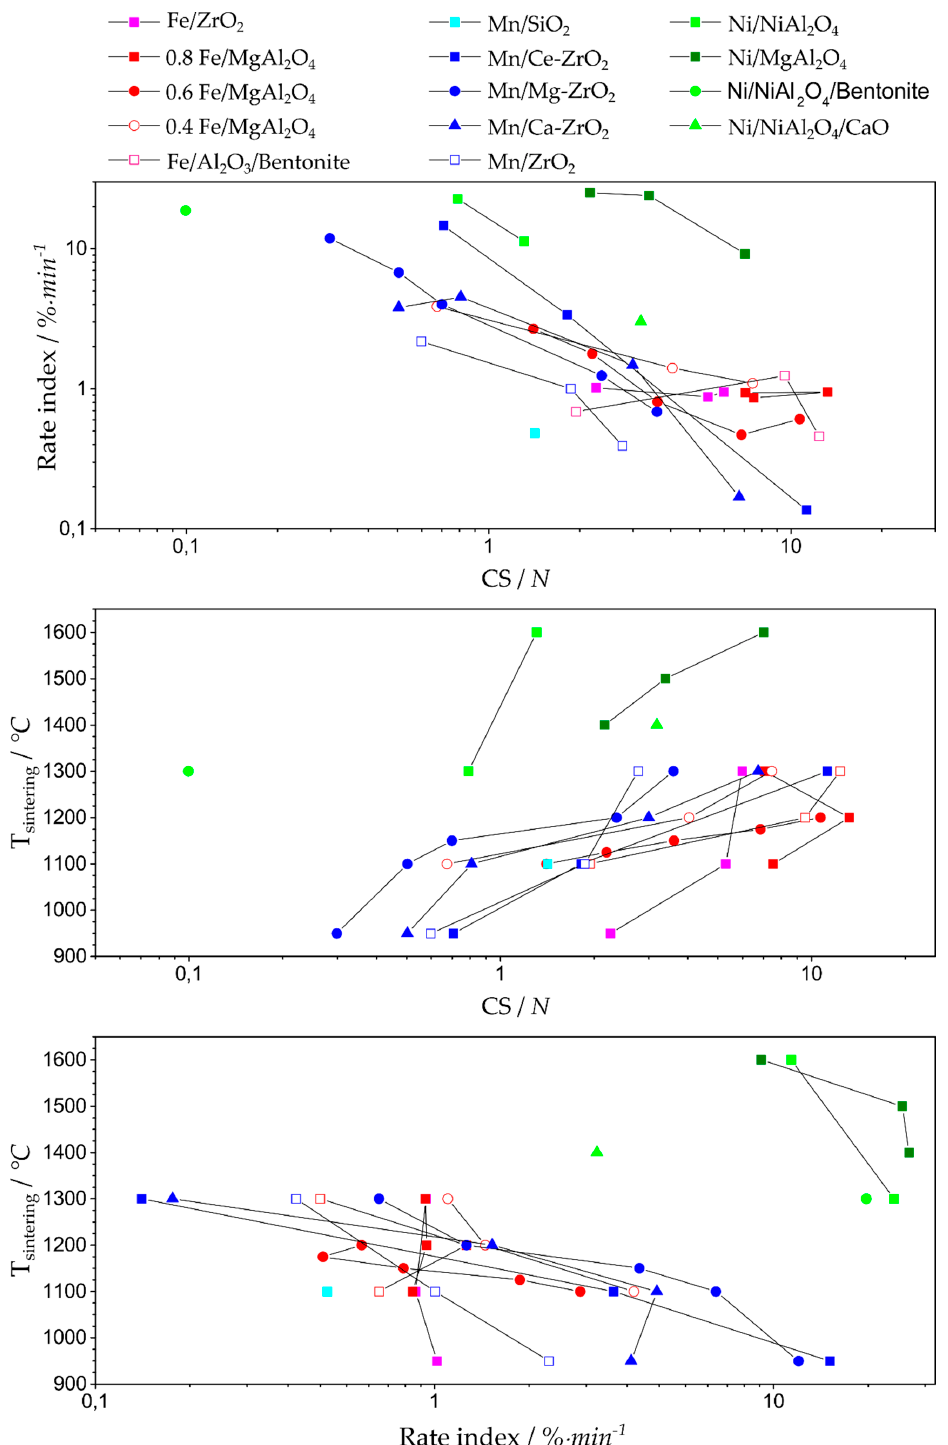
Figure 13. The relation between sintering temperature, crushing strength, and oxygen carrier reactivity of several batches of freeze granulated oxygen carriers synthesized from Mn, Ni, and Fe-based active phases, combined with di ff erent supports. The data is collected from Johansson et al. [257].